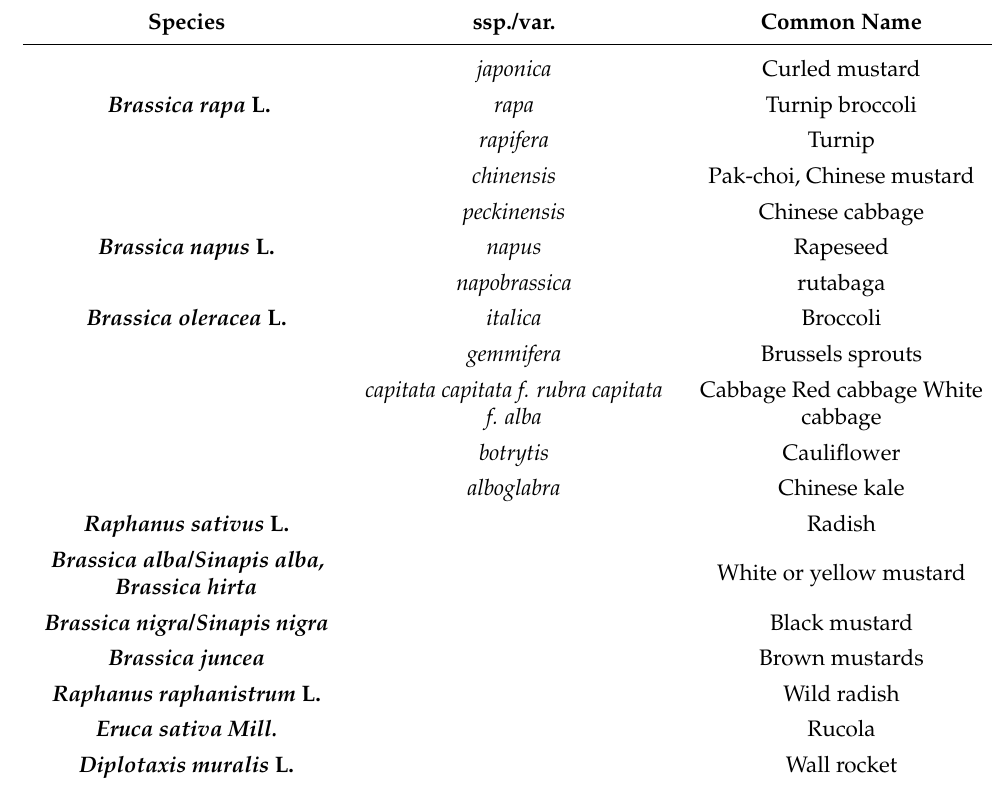
Table 1. Classification of Brassicaceae family (main species, subspecies (ssp.), and varieties (var.)) [5,8–11]. Species